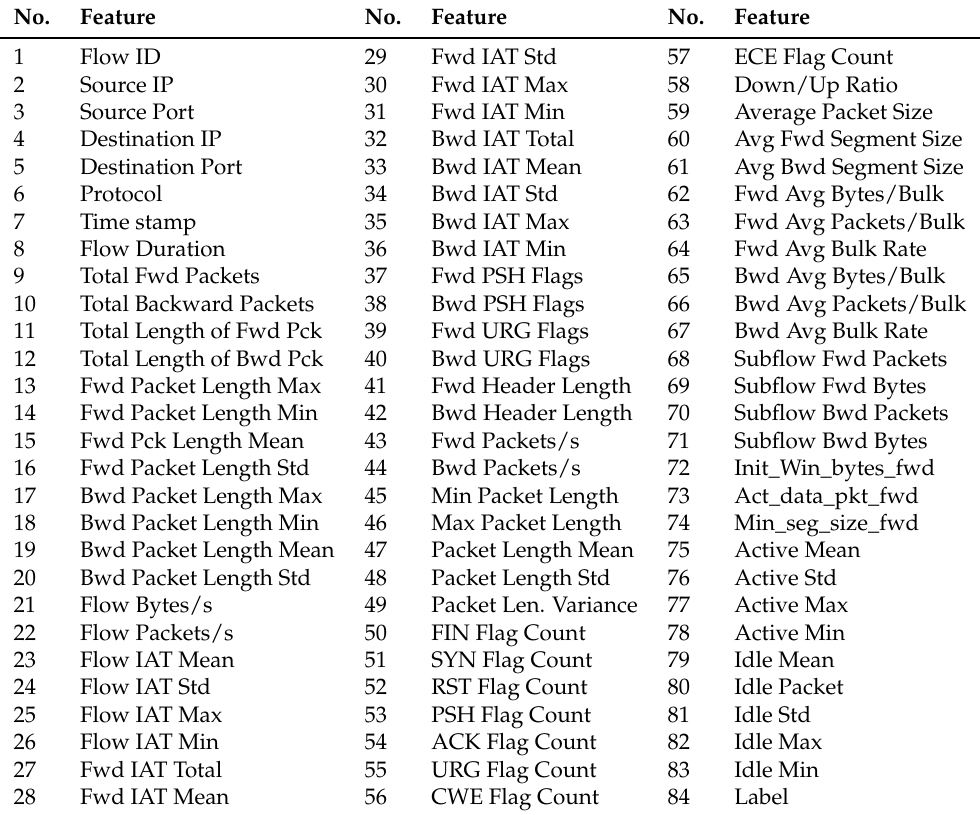
Table 3. Listed features of network traffic in